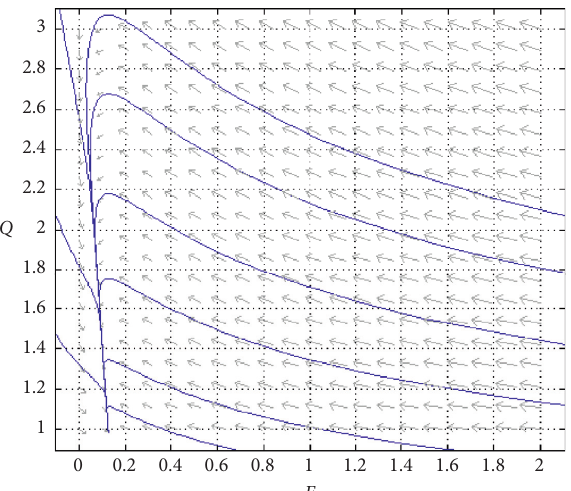
Figure 4: Behaviour of population exposed to